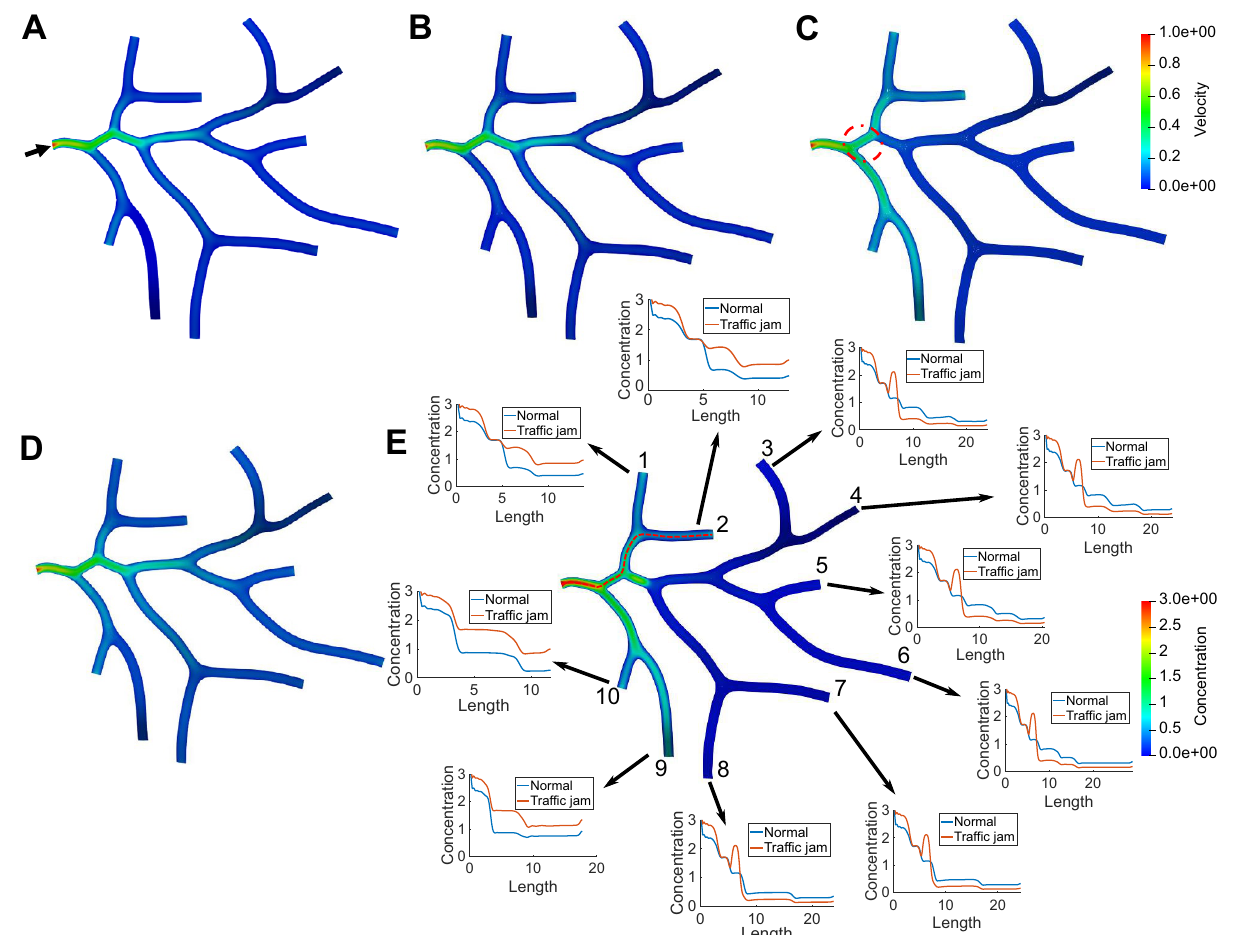
Figure 4. Simulation of material transport in a neuron tree extracted from NMO_54499. ( A ) The predefined velocity field V + . Black arrow points to the inlet of the material. The computed velocity field in ( B ) a healthy neuron and ( C ) an abnormal neuron with reduced MTs in the red dashed circle region. Distribution of concentration ( n 0 + n + ) and the concentration curve on the centerline of the circled region in ( D ) a healthy neuron and ( E ) an abnormal neuron. We also compare the concentration curve on the centerline from the inlet to every outlet between normal and abnormal transport in ( E ). The red dashed curve shows the centerline from the inlet to one of the outlets and each outlet is indexed by a unique number. Unit for color bars: ( A – C ) µ m/s 2 and ( D , E ) mol/ µ m